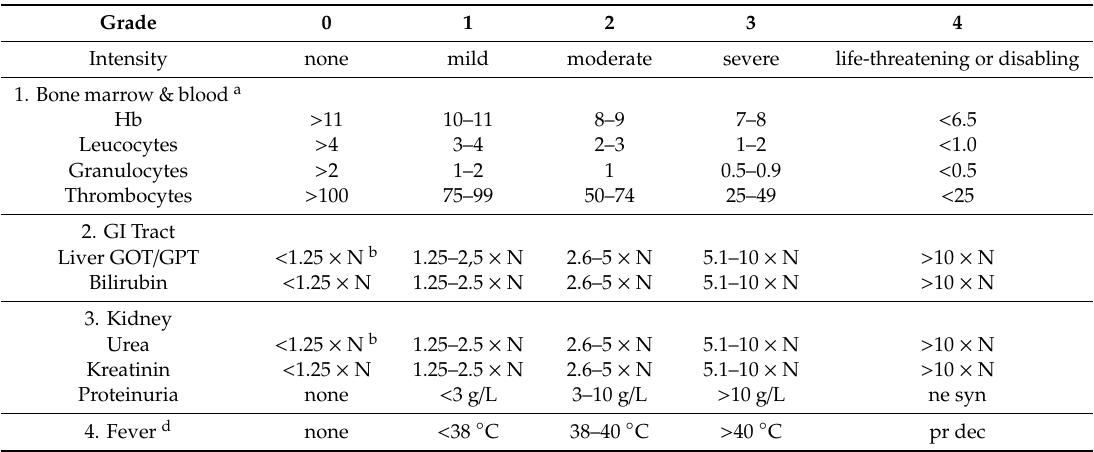
Toxicity of approved cytostatic drugs according to World Health Organization (WHO)